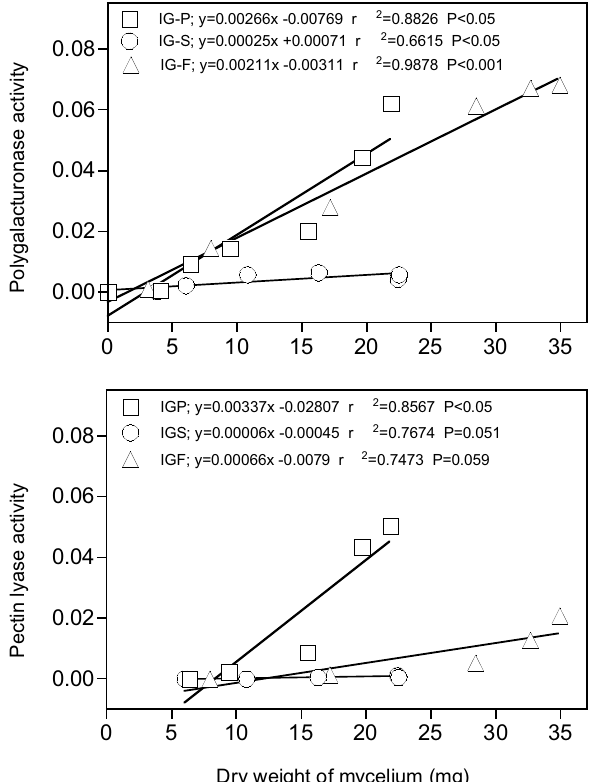
Fig. 3. Relation between growth, expressed as mg of dry weight mycelial mass, and polygalacturonase and pec- tin lyase activity, expressed as reducing units and units per ml culture filtrate respectively, by the intersterile groups (IGs) P (- (cid:1) -), S (- (cid:2) -) and F (- (cid:1) -) of Heterobasi- dion annosum grown in liquid nutrient medium with 1% pectin as the sole carbon source.